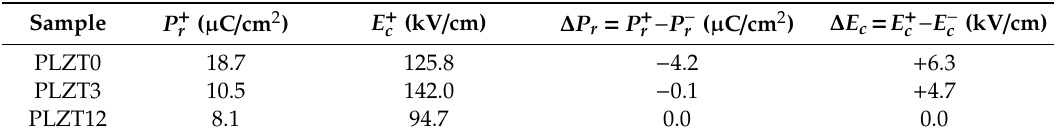
Figure 1. P-E hysteresis loops at a frequency of f = 10 Hz for the studied PLZT0 ( a ), PLZT3 ( b ) and PLZT12 ( c ) thin films. Table 1. Summary of remanent polarization ( P + r ), electric coercive field ( E + c ) and di ff erences in remanent polarization ( ∆ P r ) and electric coercive field ( ∆ E c ).